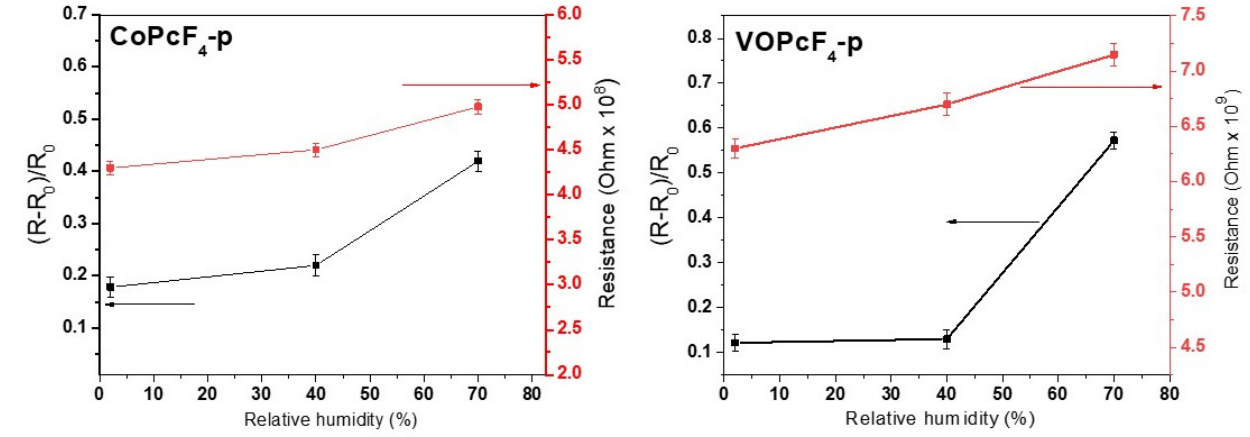
Figure 11. The sensor response of CoPcF 4 -p and VOPcF 4 -p films to ammonia (3 ppm) and the change in their resistance at different humidity.